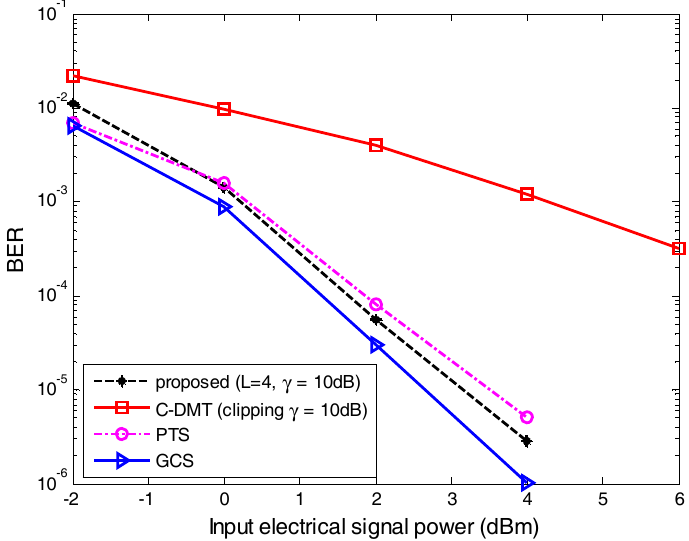
Figure 10. Comparisons of BER performance.